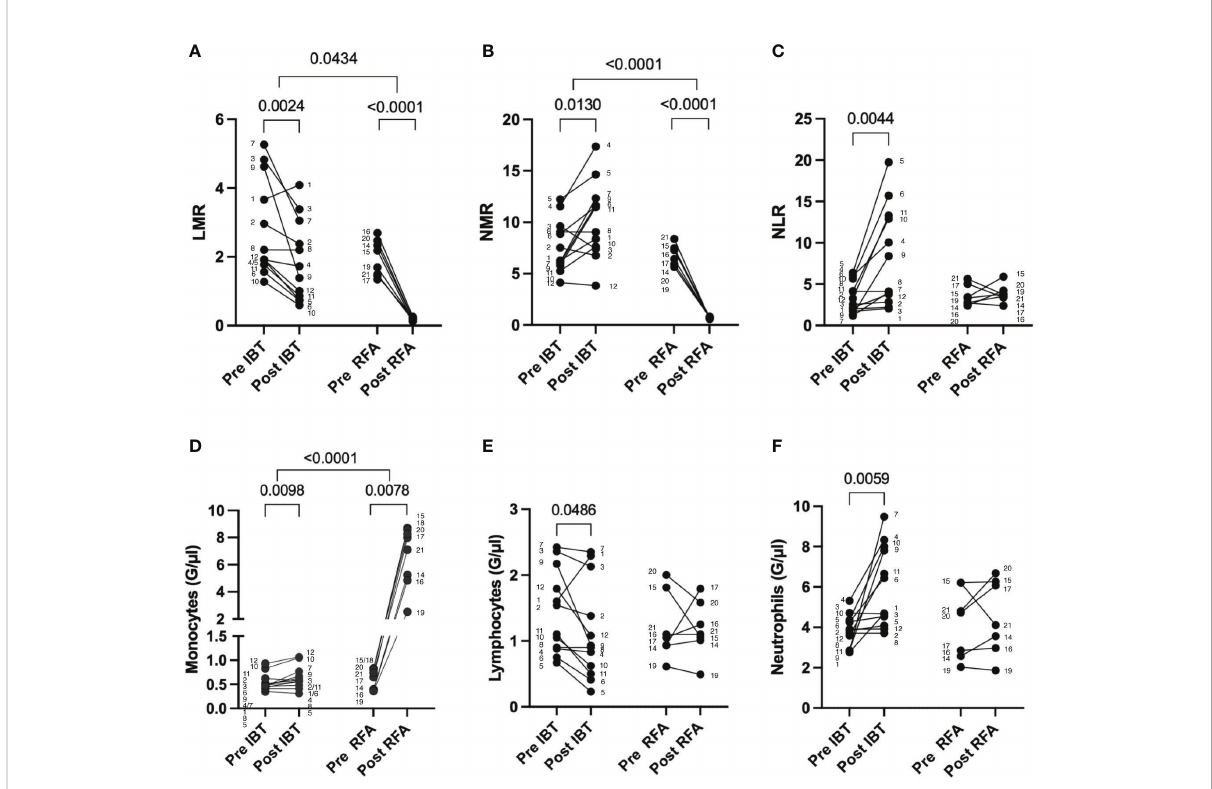
FIGURE 3 Leukocyte changes following different local ablation treatments. Pre and post analysis of (A) LMR, (B) NMR, (C) NLR, (D) monocytes, (E) lymphocytes, and (F) neutrophils. Differential blood values from 12 IBT- and 7 RFA-treated patients were analyzed. Each dot represents an individual patient. Numbers next to dots represent patient IDs and ensure assignment of pre and post values. Data were analyzed using paired t -test (IBT: B, C, E , and F; RFA: A – C, E, F ) or Wilcoxon-test (IBT: A, D ; RFA: D ). Intraindividual differences were analyzed using unpaired t -test (A, B, D – F) or Mann – Whitney U -test (C) . p -values < 0.05 indicate statistical signi fi